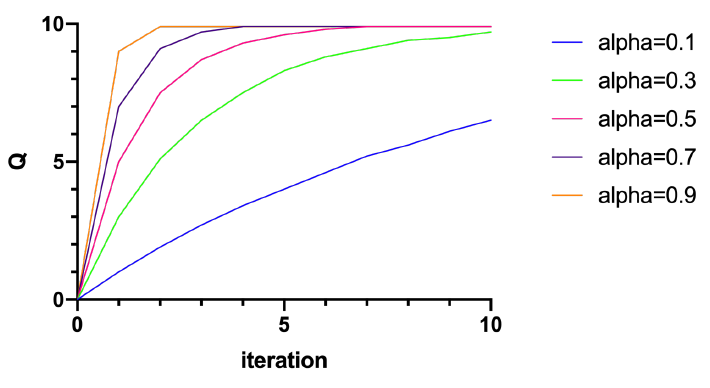
Figure 17. Learning